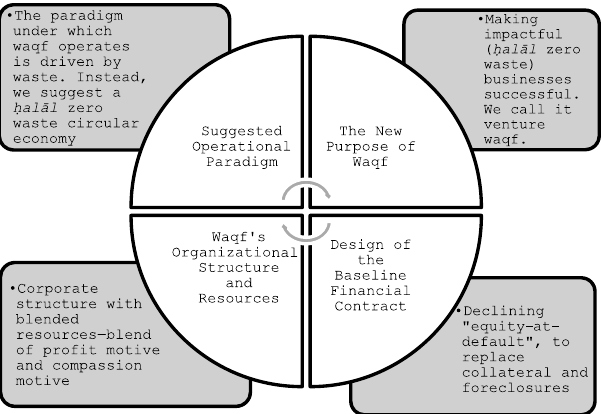
Figure 2. Integrated